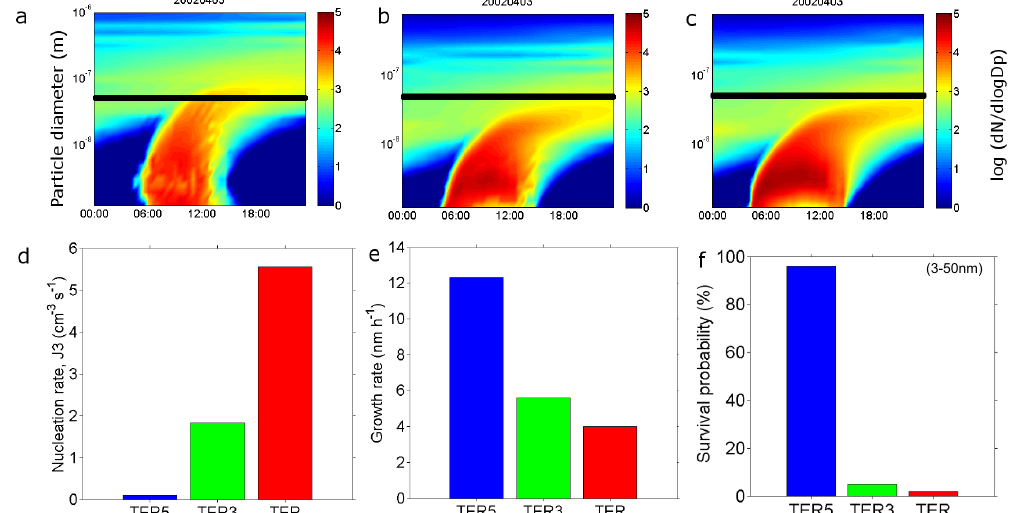
Figure 6. Nucleation metrics and number size evolution plots for 3 April 2002 (local time) at Hyytiälä. Panel (a) is the size distribution evolution for the TER5 simulation, panel (b) is the same for the TER3 simulation, and panel (c) is the TER simulation. The bottom row (panels d through f ) shows the nucleation rate, growth rate (3–25nm), and survival probability to 50nm (multi-day) for each of the three ternary nucleation scenarios. The heavy black line indicates the 50nm size threshold used for this